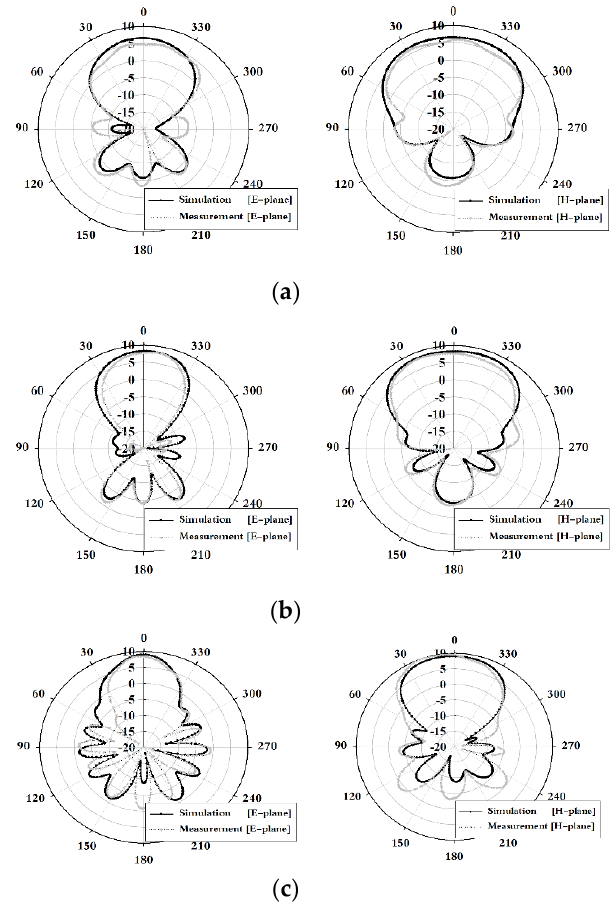
Figure 4. Simulation and measurement results of the radiation pattern: ( a ) 3, ( b ) 4, and ( c ) 5 GHz.